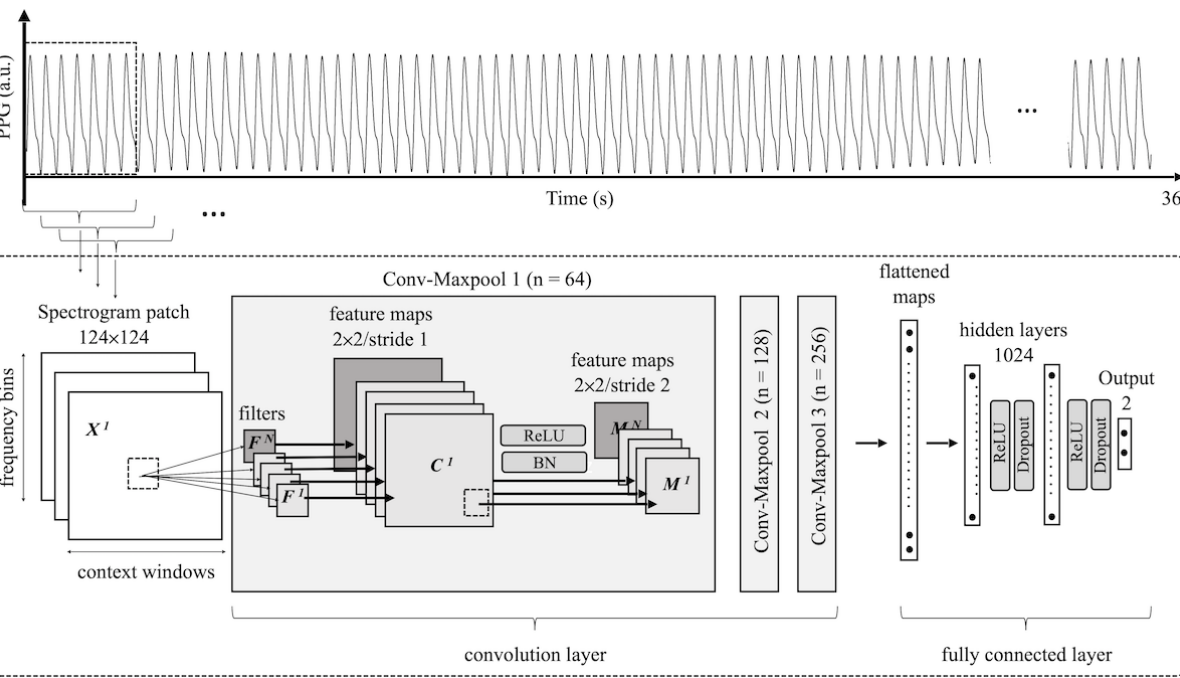
Figure 2. Architecture of the convolutional neural network proposed in this study. X: input, F: filter, C: convolution layer, M: max pooling, N: number of filters, BN: batch normalisation, ReLU: rectifier linear unit, Conv-Maxpool: convolution-max